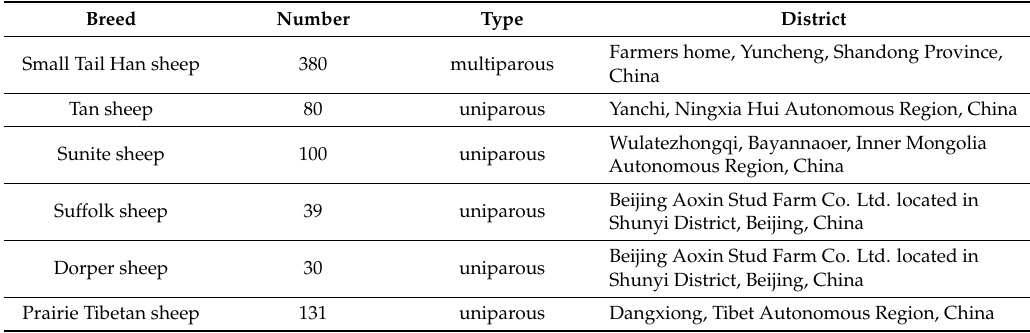
Table 1. Information of six sheep breeds selected for